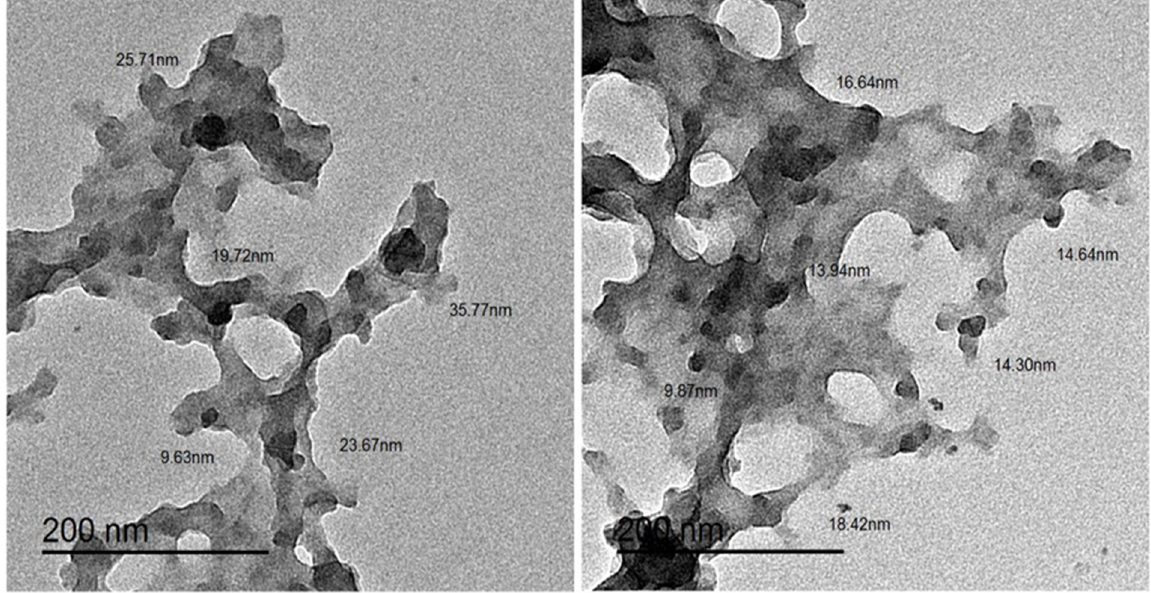
Figure 3. Band gap energy of the biosynthesized ZnO nanoparticles using the Tauc plot method.